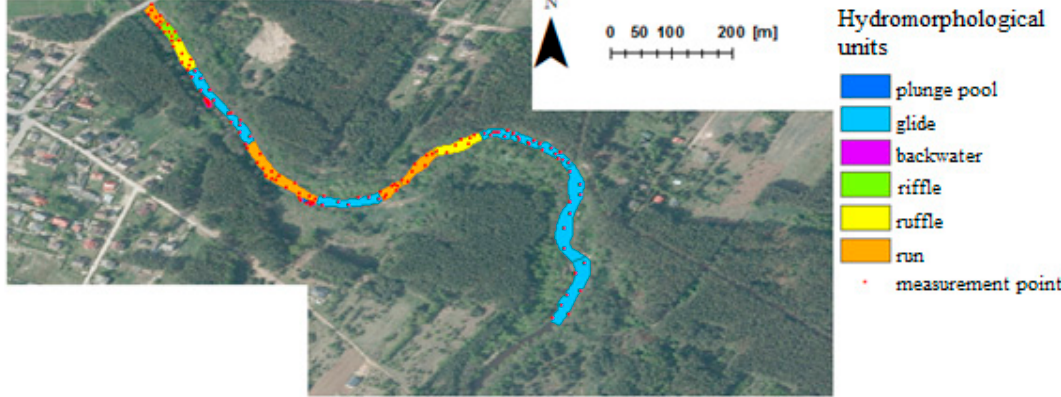
Figure 2. Specified hydromorphological units and measurement points obtained after field studies on the analyzed section of the Swider River (reference conditions).